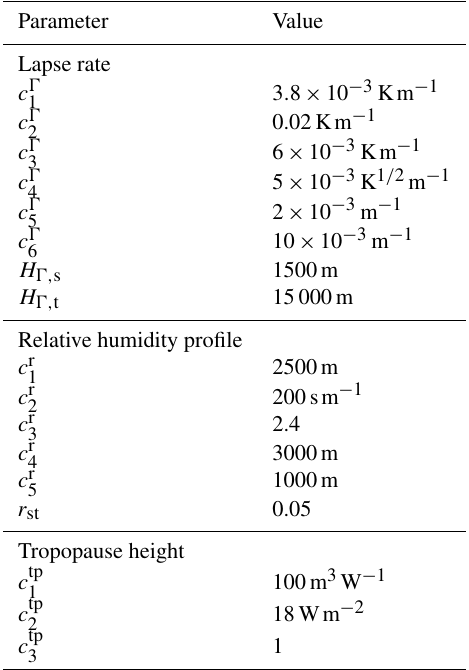
Table A1. Parameters for vertical